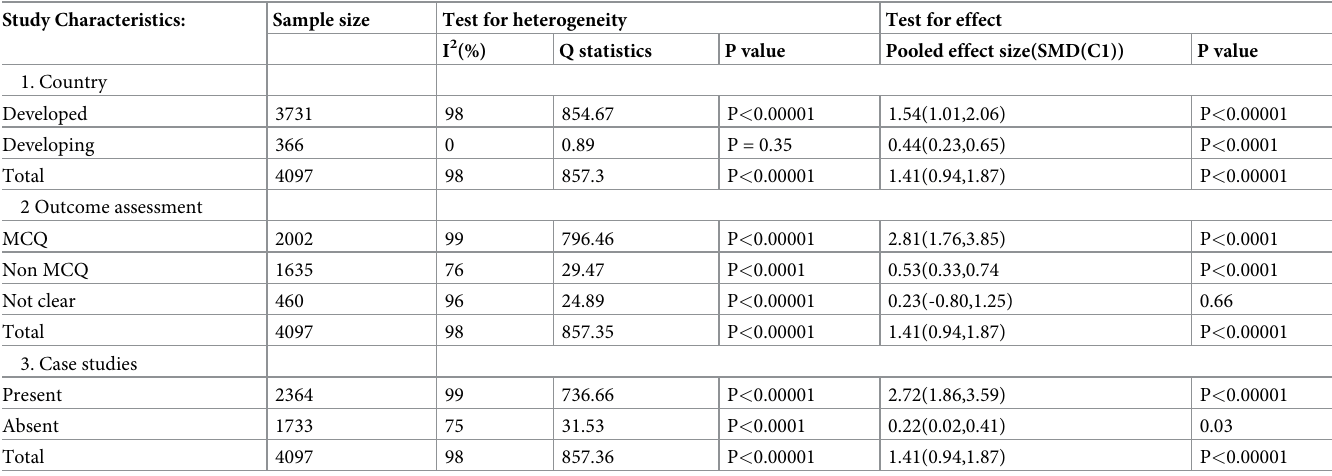
Table 2. Subgroup analysis of cohort